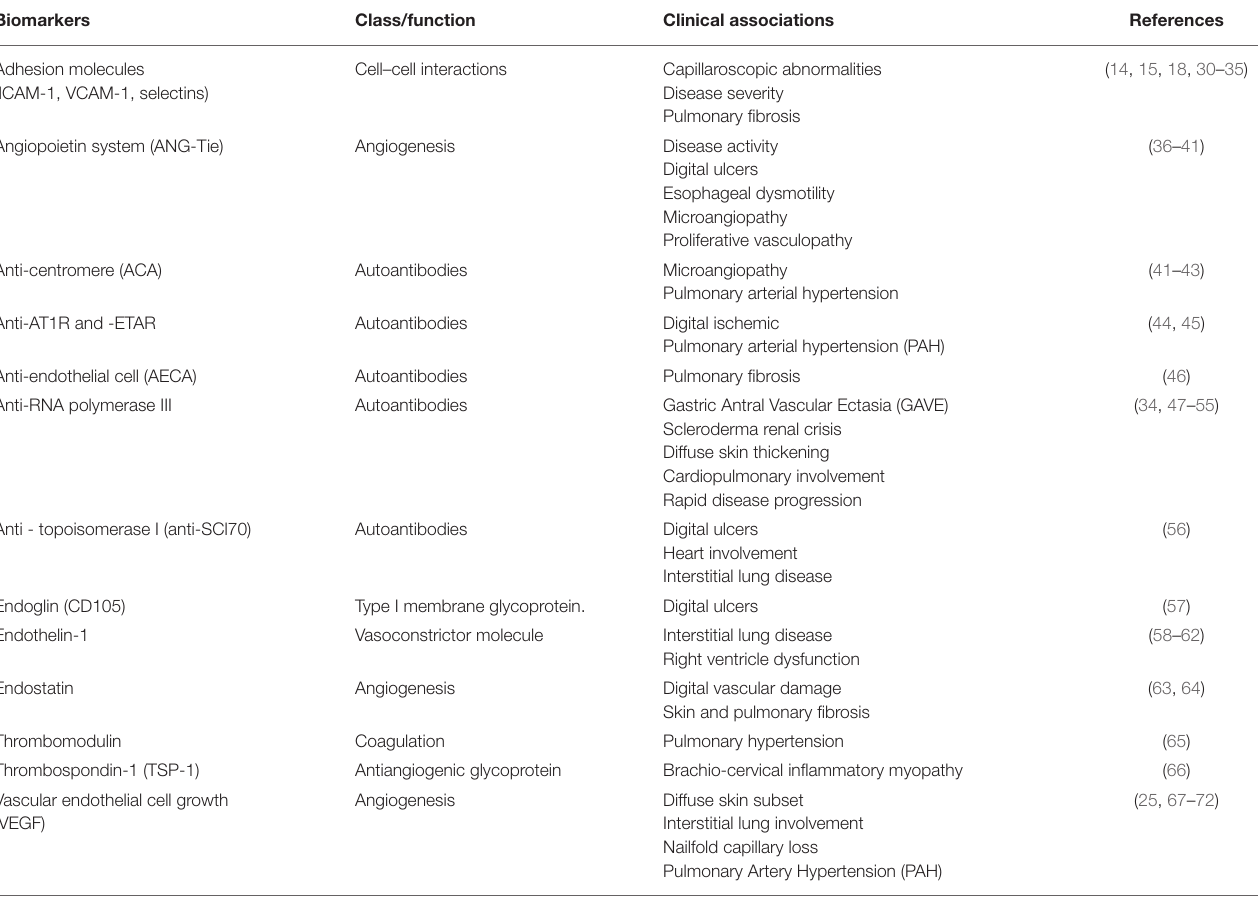
TABLE 1 | Biomarkers associated with endothelial activation or vascular damage in SSc and clinical